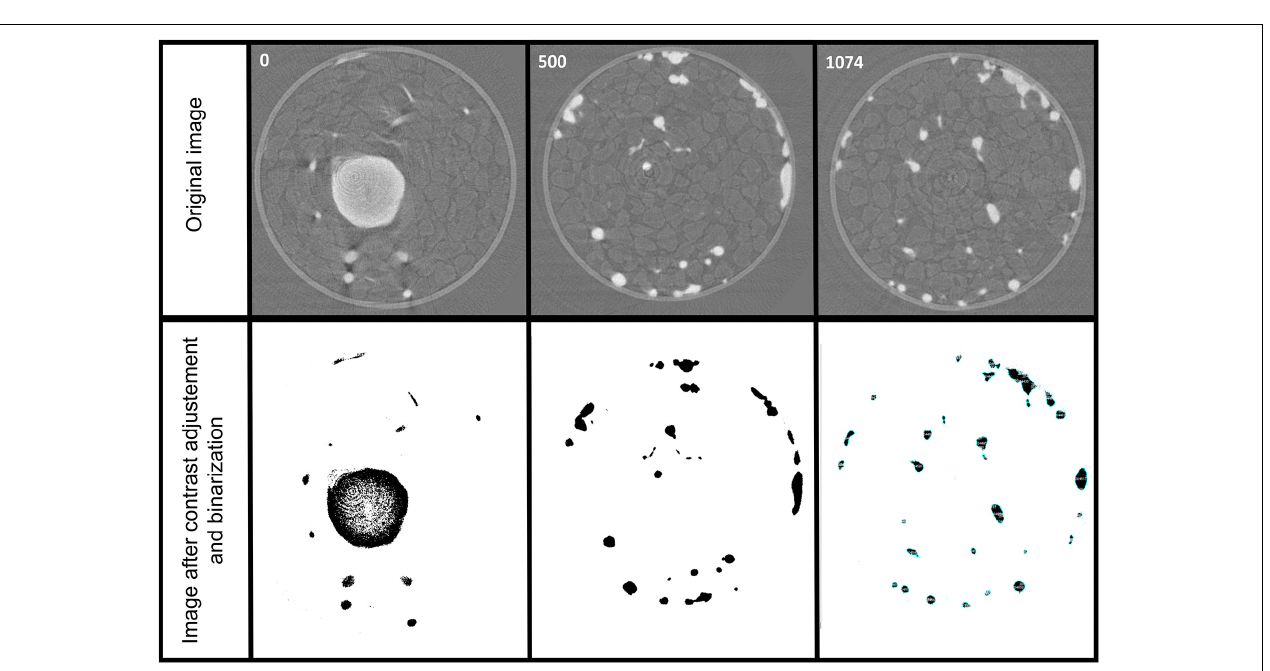
FIGURE 8 | Reconstructed tomography obtained for grapevine roots. The grapevine herbaceous cutting has been grown in a sample holder filled with sand. The dense 3D architecture of the roots is clearly observed in (A) . A slide at the bottom of the sample holder is presented in (B) . A threshold has been used to specifically contrast the roots from the sand and the sample holder (this 3D volume visualization is performed with the Avizo Fire 9.2 software).